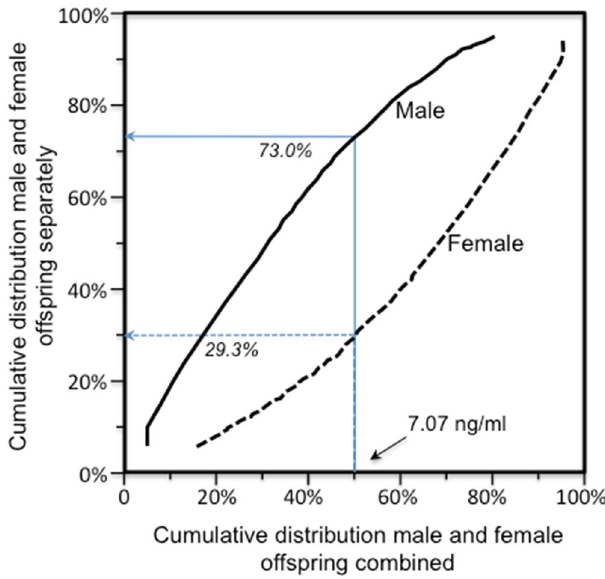
Figure 2. Probability-probability ( P – P ) plot of the distribution of leptin concentrations in males and females separately (vertical axis) versus the sexes combined, showing the percentiles of the male and female distribution having the same leptin concentration (see